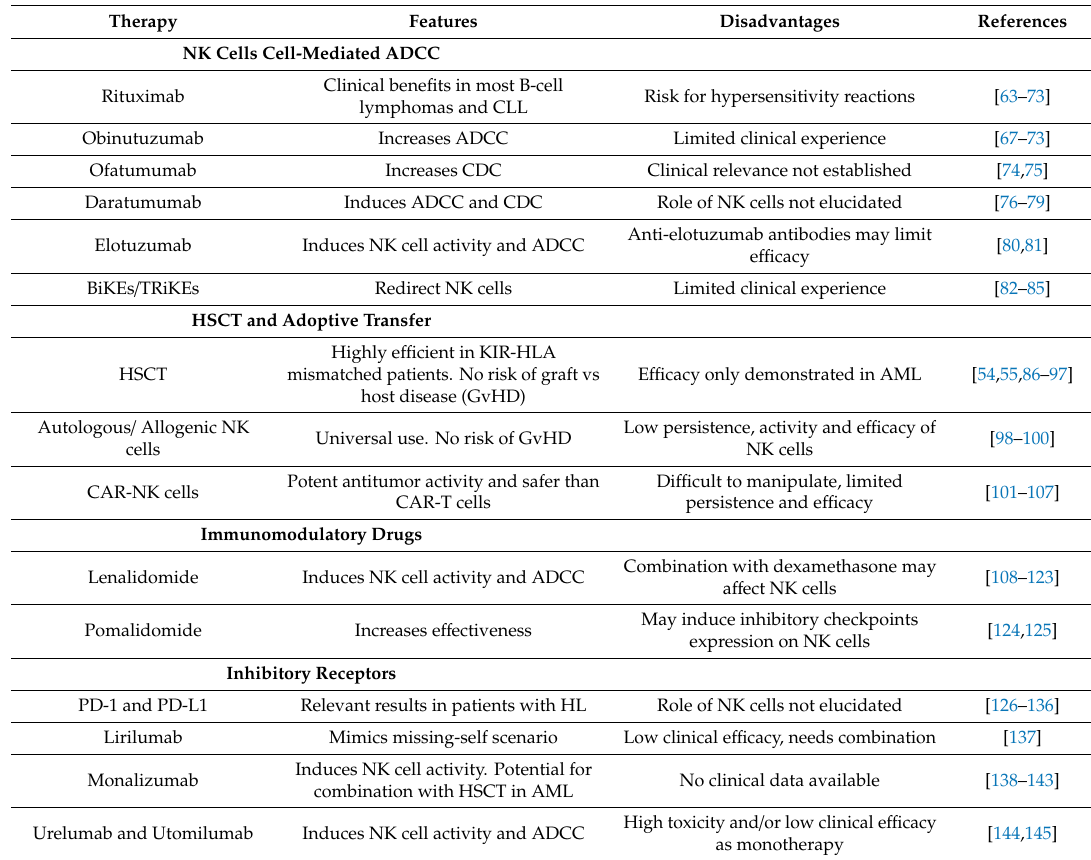
Table 2. Current and most promising NK cell immunotherapies used in hematological cancers. ADCC, antibody-dependent cell-mediated cytotoxicity; CDC, complement-dependent cytotoxicity; HSCT, hematopoietic stem cell transplantation; CAR, chimeric antigen receptor CLL, chronic lymphocytic leukemia; AML, acute myeloid leukemia; GvHD, graft-versus host